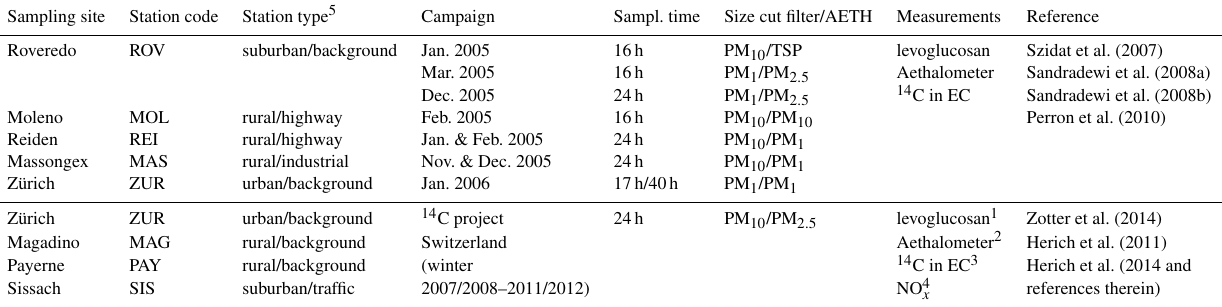
Table 1. List of all stations and their classification according to the Swiss Federal Office for the Environment (FOEN) and additional campaign